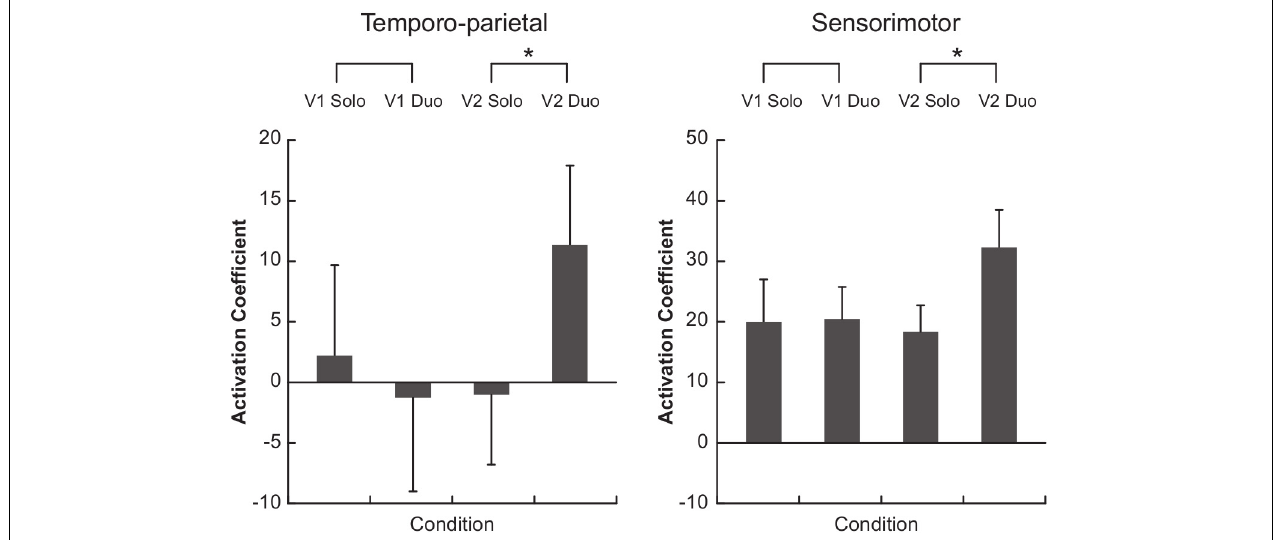
FIGURE 4 | Functional near-infrared spectroscopy (fNIRS) results. Bars represent the median of the activation coefficients (beta) across subjects ( ± 1 SEM). V1, violin 1 part; V2, violin 2 part. ∗ p <